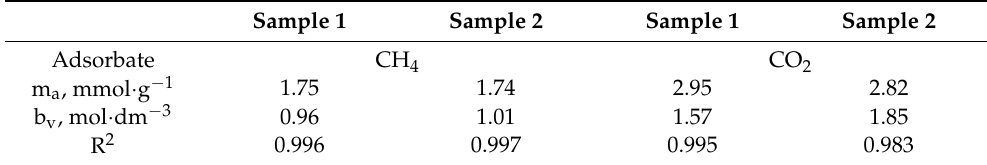
Table 3. Langmuir parameters calculated for the absolute sorption.